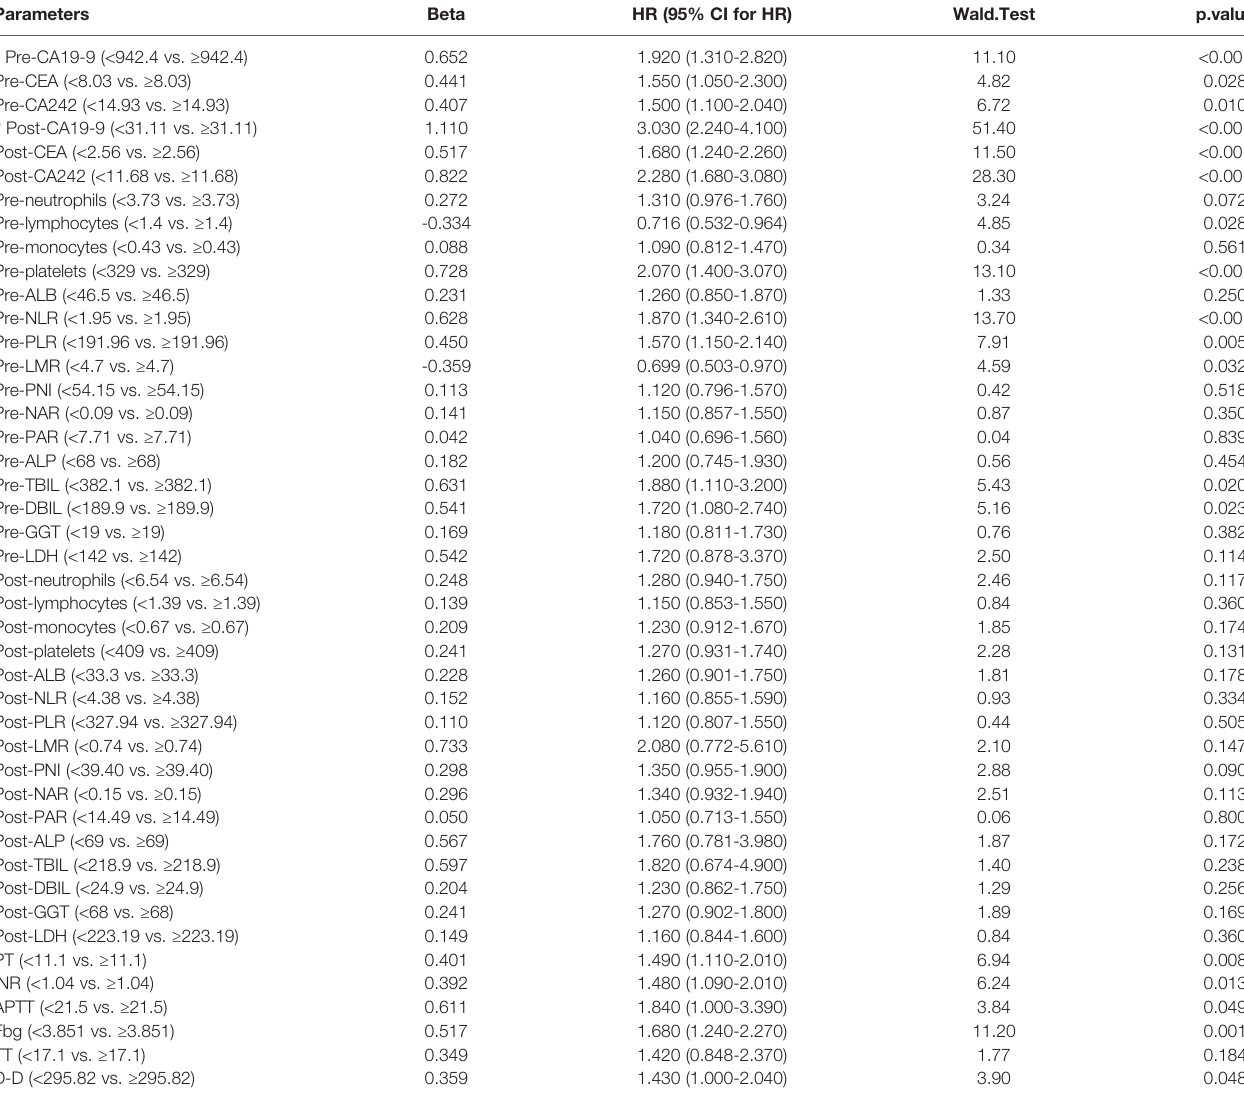
TABLE 2 | Univariate Cox regression analysis of 44 perioperative blood parameters in patients with PDAC after radical resection. Parameters